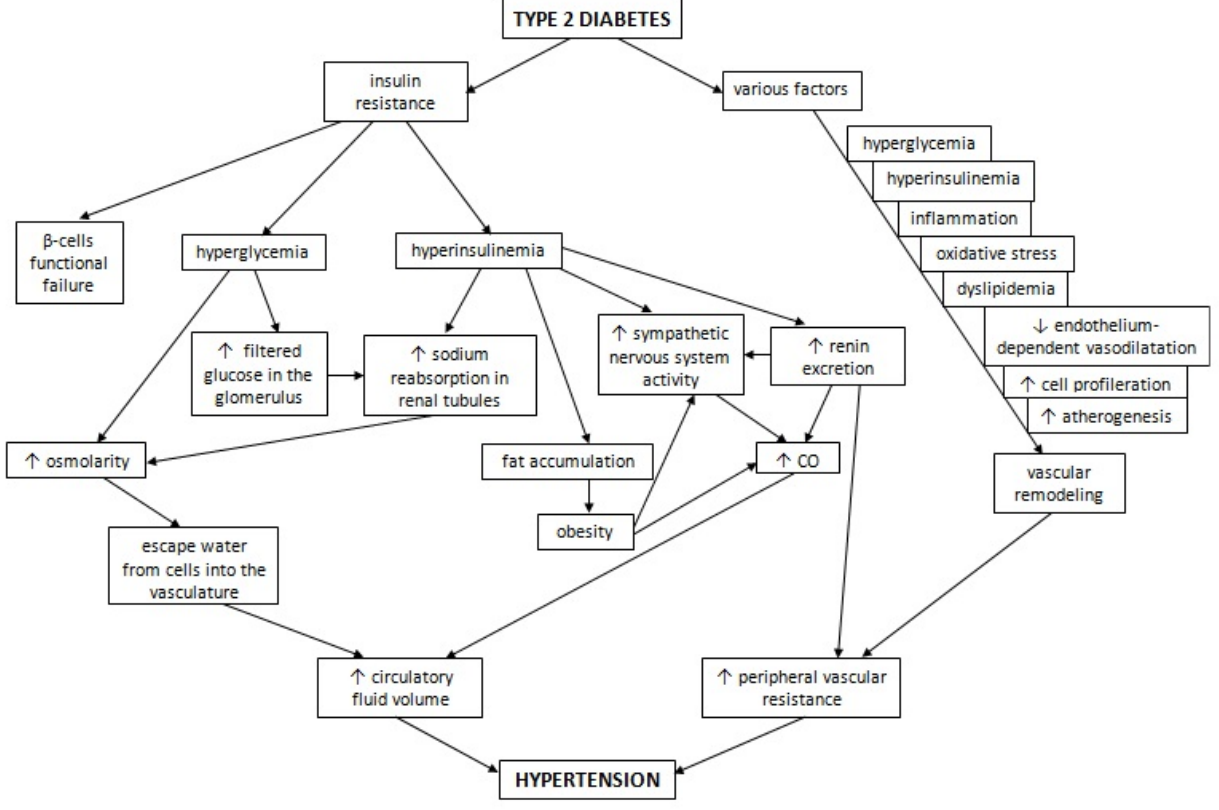
Figure 2. The influence of T2D on hypertension development.